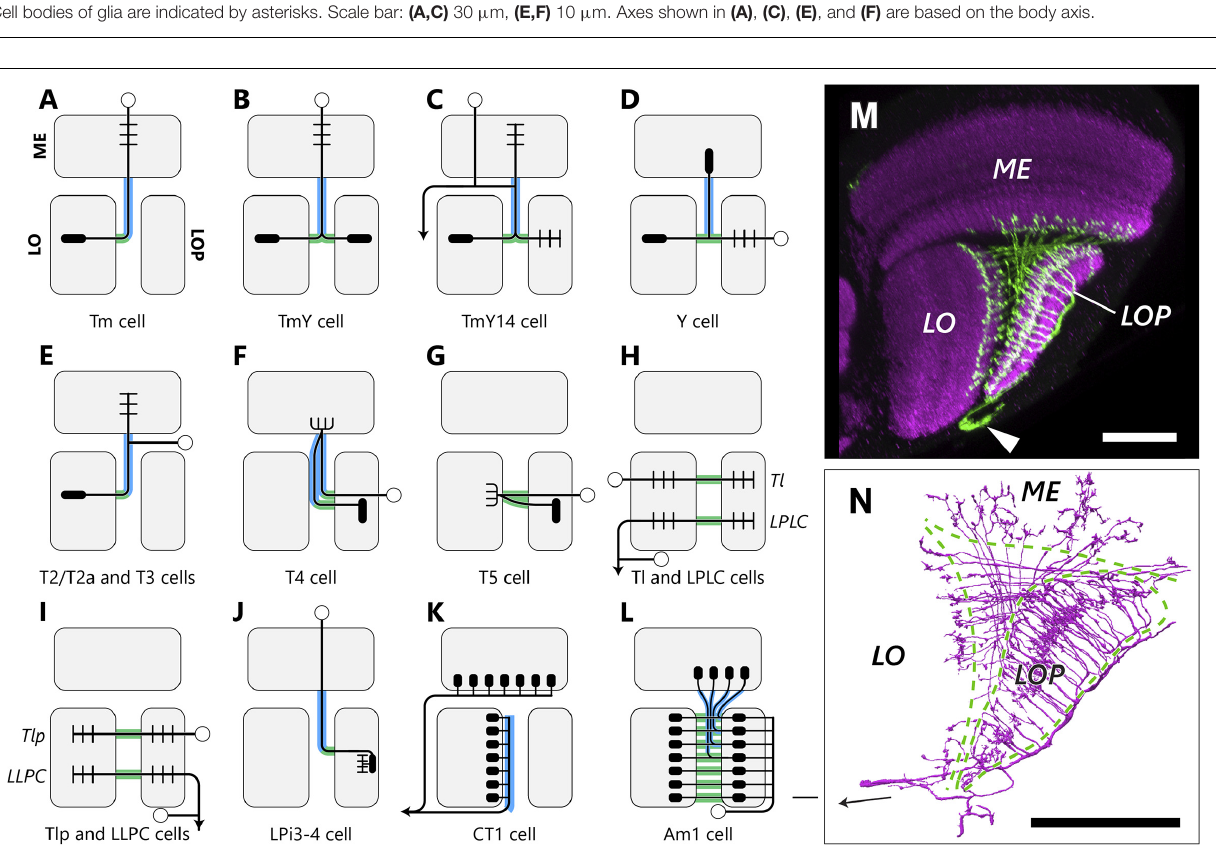
FIGURE 3 | Types and projection patterns of OCH2 neurons. (A–L) Neuron types that contribute to OCH2, and their projection patterns. Open circles indicate cell bodies, arrows indicate projections to/from the central brain in (H) , (I) and (K) . Short lines indicate typical input (dendritic/postsynaptic) neurites, and filled ellipses indicate typical output (axonal/presynaptic) neurites. Neuron arbors shown are considerably simplified, and pre- and postsynaptic motifs almost always coexist at single neurites in actual neurons, so that input and output sites are therefore not strictly segregated. Lines shown in green and blue, respectively, correspond to neuronal fibers in the bundles and sheets. (M) The Am1 cell visualized with FLP-out. Arrowhead indicates the cell body. (N) To compare with (M) , Am1 reconstructed from the FIB-SEM dataset. The arrow in (N) indicates the cell body fiber. Scale bar: (M,N) 30 µ